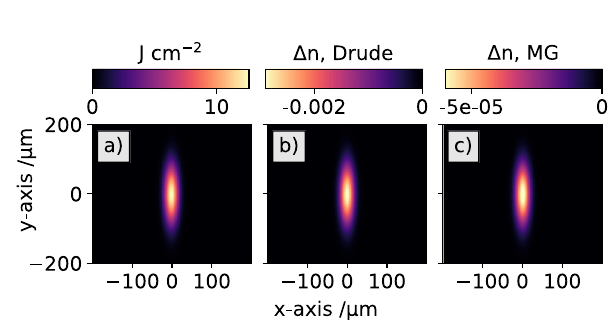
Fig. 8 | Fluence-dependent refractive index change. Analysis of the expected transient refractive index change with the experimentally used X-ray beam pro fi le. The calculated fl uence of the used X-ray beam is shown in ( a ). The expected tran- sientrefractiveindexchangesindiamondcalculatedfromthe fl uenceareshownin ( b ) for the Drude model and ( c ) for the Maxwell-Garnett (MG) model. Please note the very different scales for each color bar.